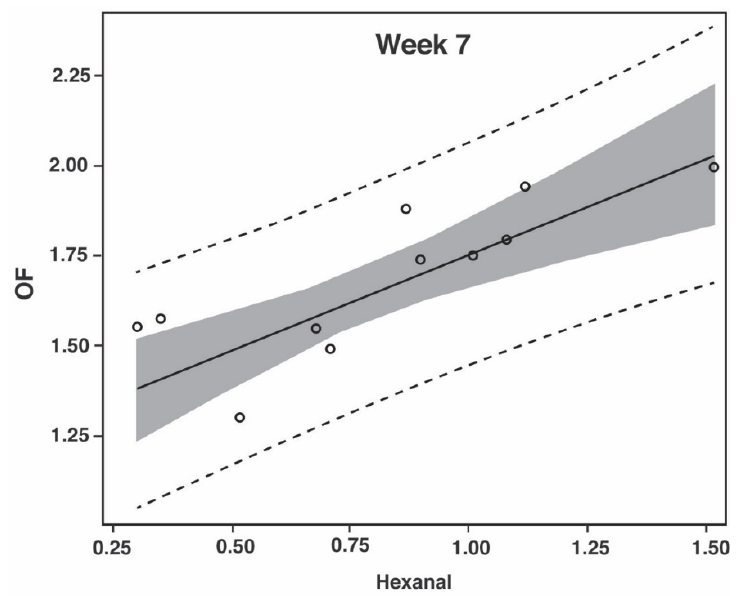
Figure 1. Prediction plot for off-flavor (OF) from headspace hexanal when examining chicken fillet at week 1 (R 2 = 0.332; P = 0.031) and week 7 (R 2 = 0.649; P = 0.001) of refrigerated storage. Dashed lines provide the 95% prediction limits. The shaded area is the 95% confidence limits of the fit. The finished product was thermally processed and modified atmosphere packaged in 75% N 2 and 25% CO 2 . The off-flavor scale was 0 to 15 with 15 being highest off-flavor. Units for hexanal were mg per kg (weight/weight).